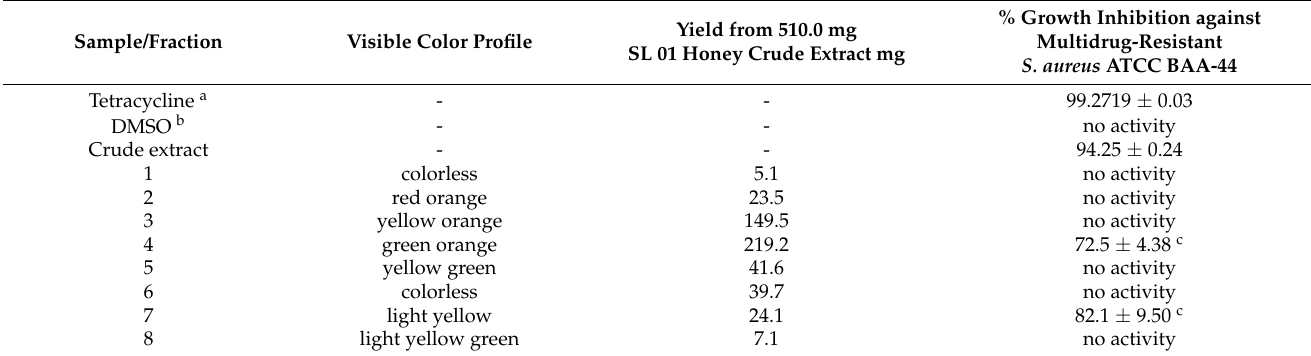
Table 4. Gel Permeation Chromatography (GPC) Purification of SL 01 Honey Crude Extract Showing Eight Major Fractions, Color Profile and Yield and Antibiotic Activity against Multidrug-resistant S. aureus ATCC BAA-44. Sample/Fraction Visible Color Profile